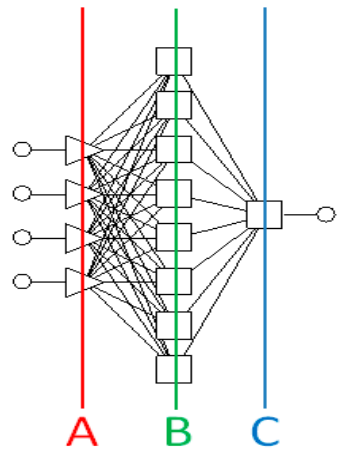
Figure 2. Structure of a multilayer perceptron (MLP) network with 1 input layer, 1 output layer, and 1 hidden layer: A—input layer; B—hidden layer; C—output